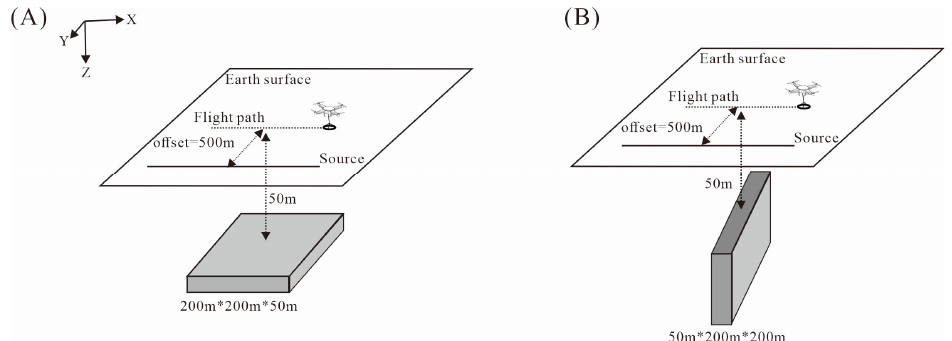
Figure 2. Plate models ( A ) Horizontal plate; ( B ) Vertical plate.